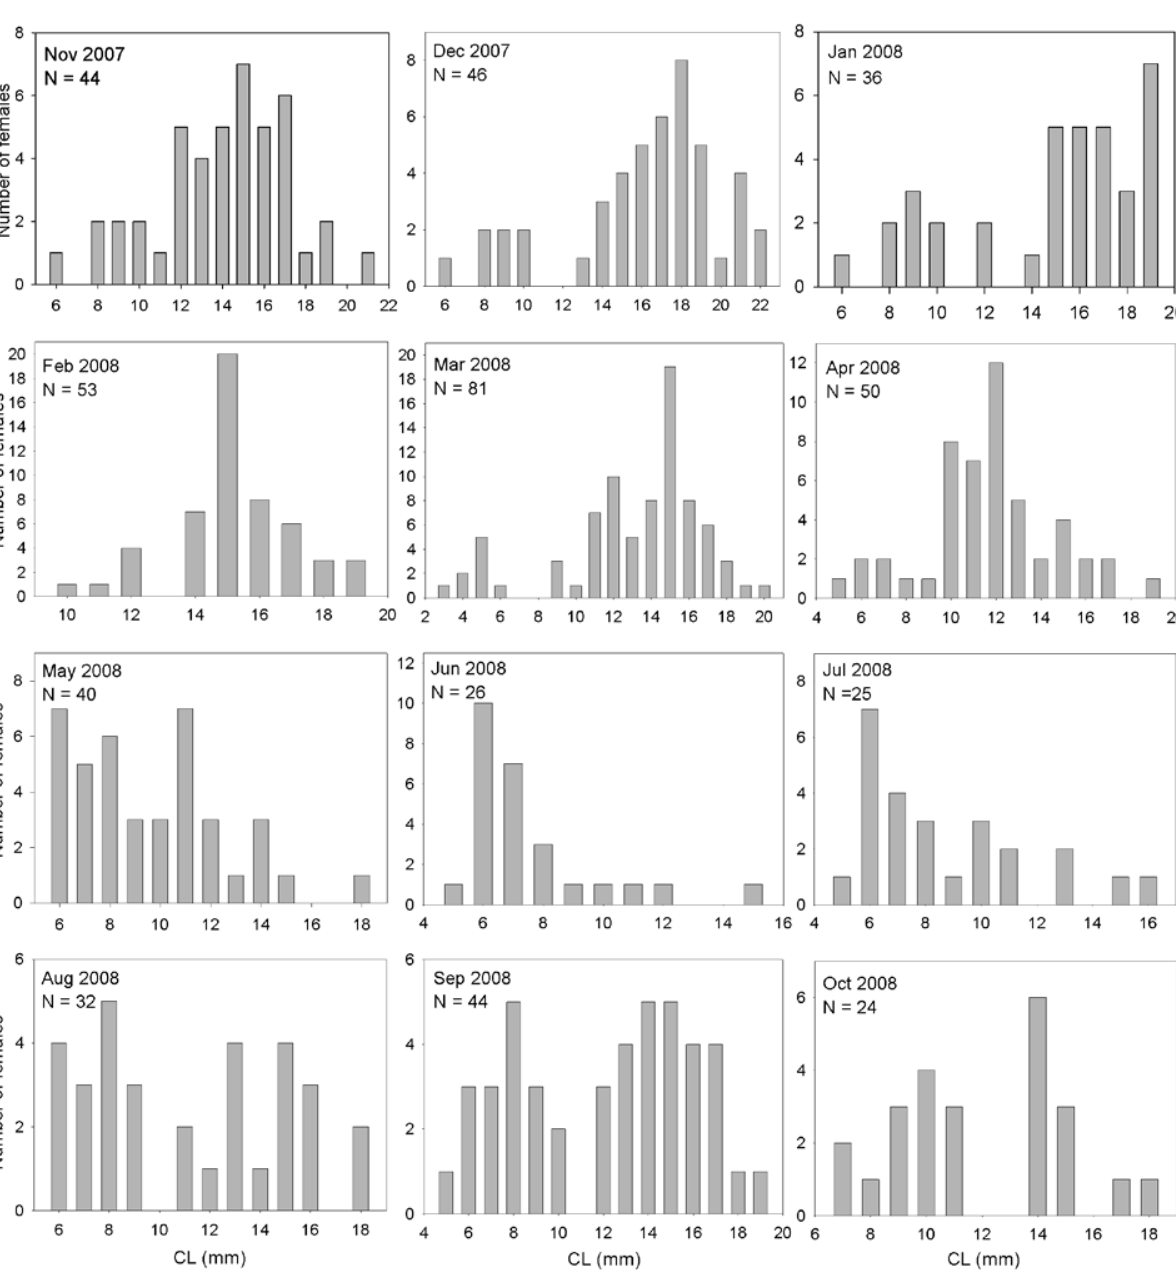
10Figure 3. Absolute frequency distribution of cephalothoracic length (CL) (mm) classes of Aegla georginae females, Perau Creek, Ibicuí Basin,